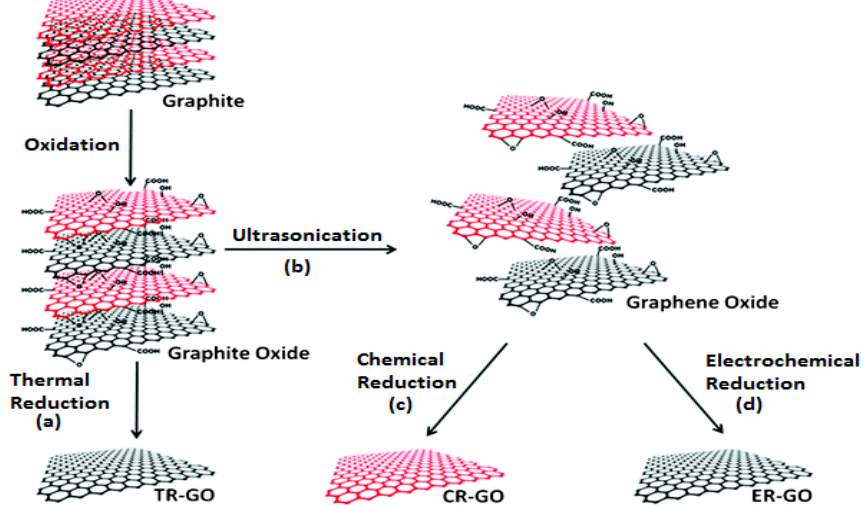
Figure 3. Schematic representation of the synthesis of chemically modified graphene. Adapted from [63], with permission from ©2012 Royal Society of Chemistry.